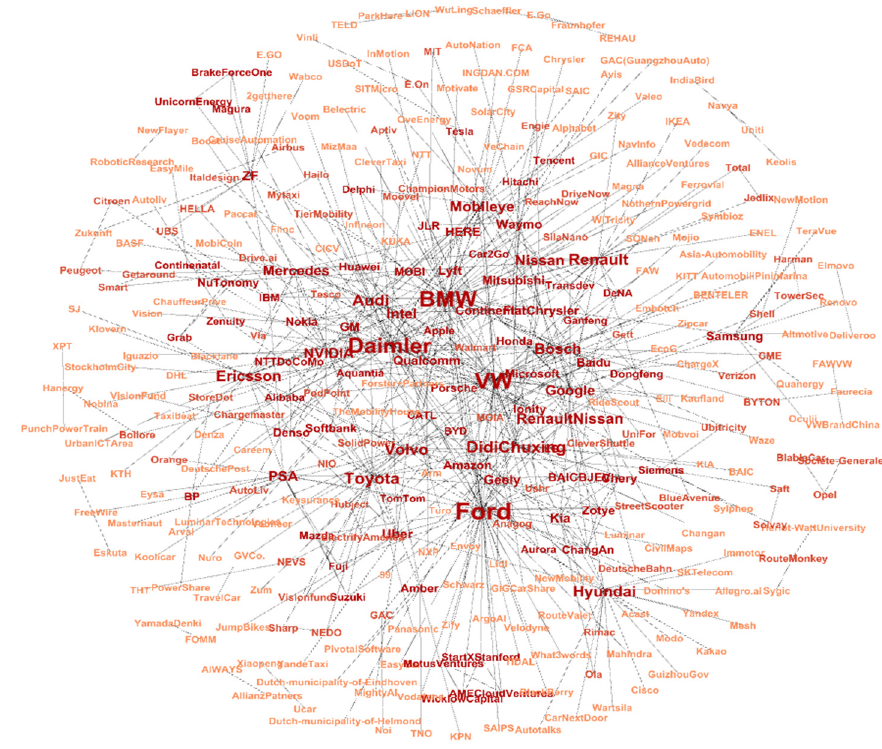
Figure 4. Automobility network to build an autonomous